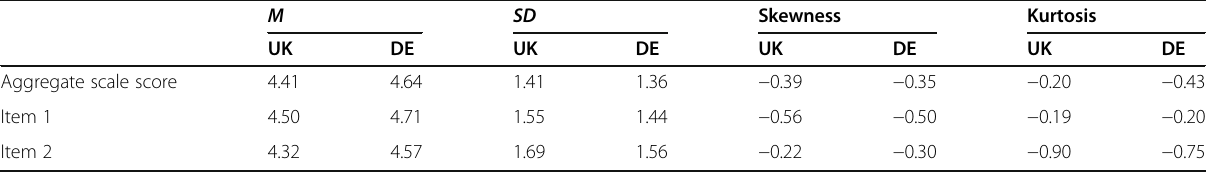
Table 4 Descriptive statistics by nation for the SOP2 items M